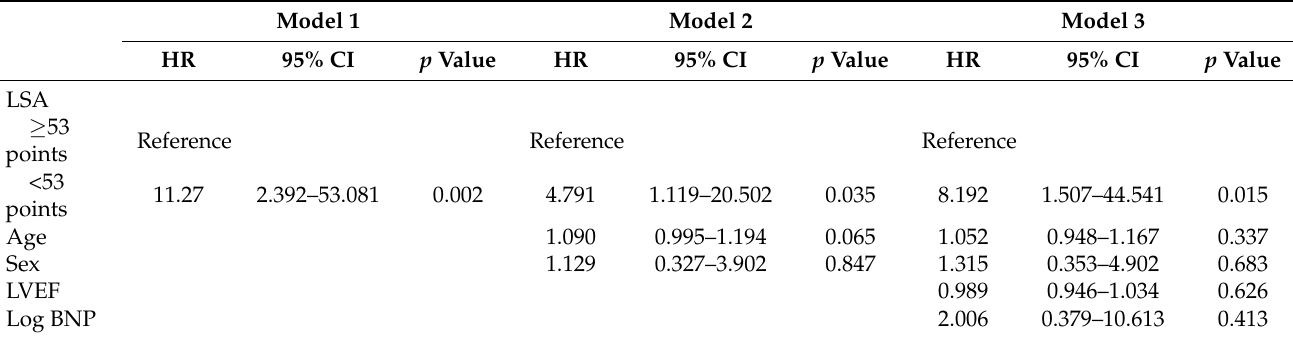
Table 4. Cox proportional hazards analysis (cardiovascular